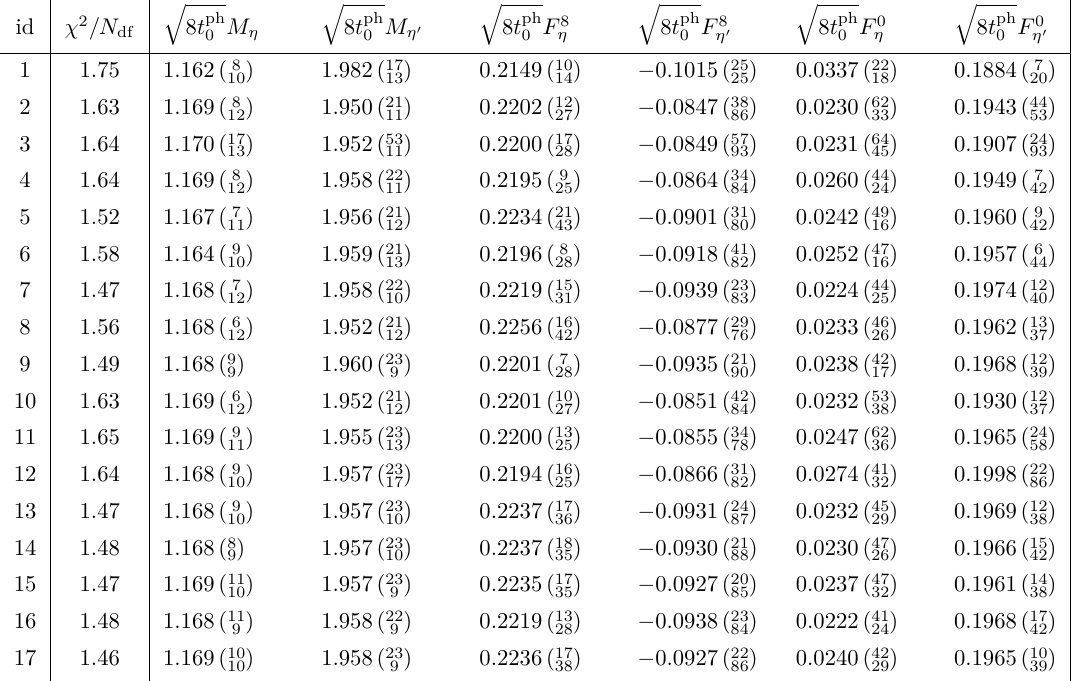
Table 9. Results for the masses and decay constants of the η and η 0 at the physical point in units of the gradient flow scale obtained when employing the fit forms detailed in table